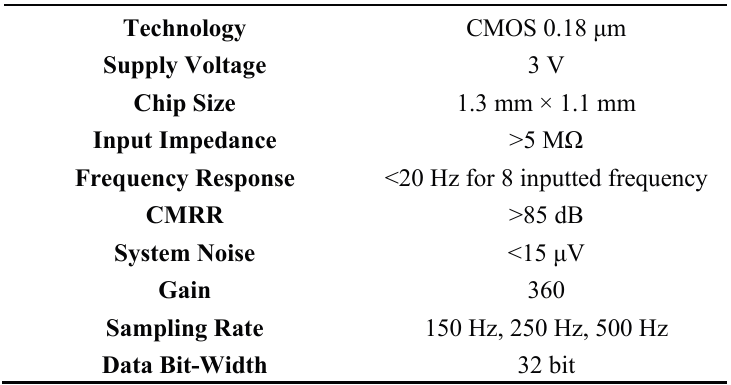
Table 1. Performance summary of the ECG sensor